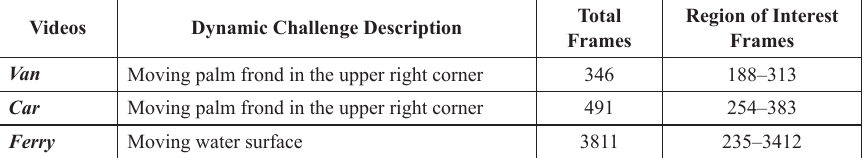
Table 1. Dynamic background videos from local dataset